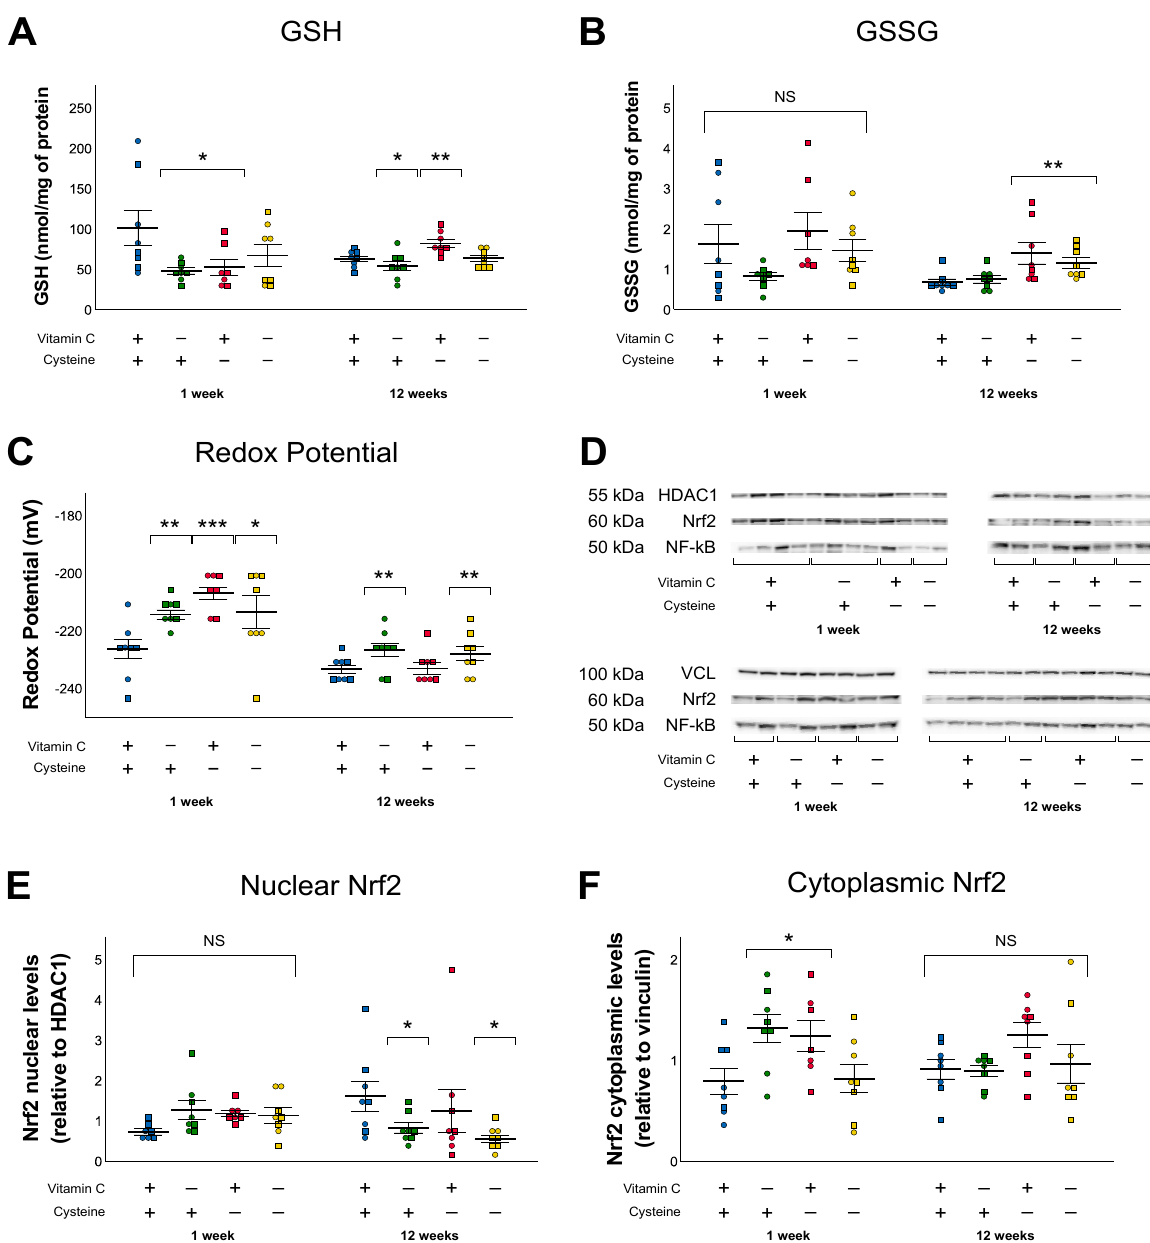
deficiency increased both GSH and GSSG levels (Figure 3A,B). Vitamin C and cysteine deficiencies both increased NF- κ B cytoplasmic levels, but the addition of their deficiencies in DD group blunted the statistical effect (Figure 3H). GSSG levels, redox potential of diets (GSSG: + 56%; redox potential: 3.6 mV; Nuclear NF- κ B: 46%), whereas cytoplasmic Nrf2 was lower in females, compared to males ( − 18%).